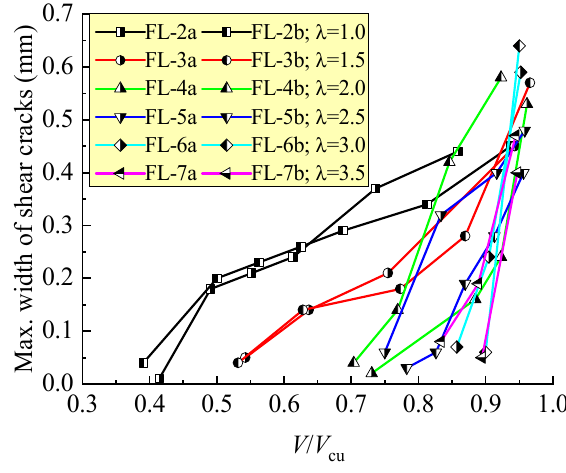
Figure 5. Maximum width of shear crack on test beams with a different λ .